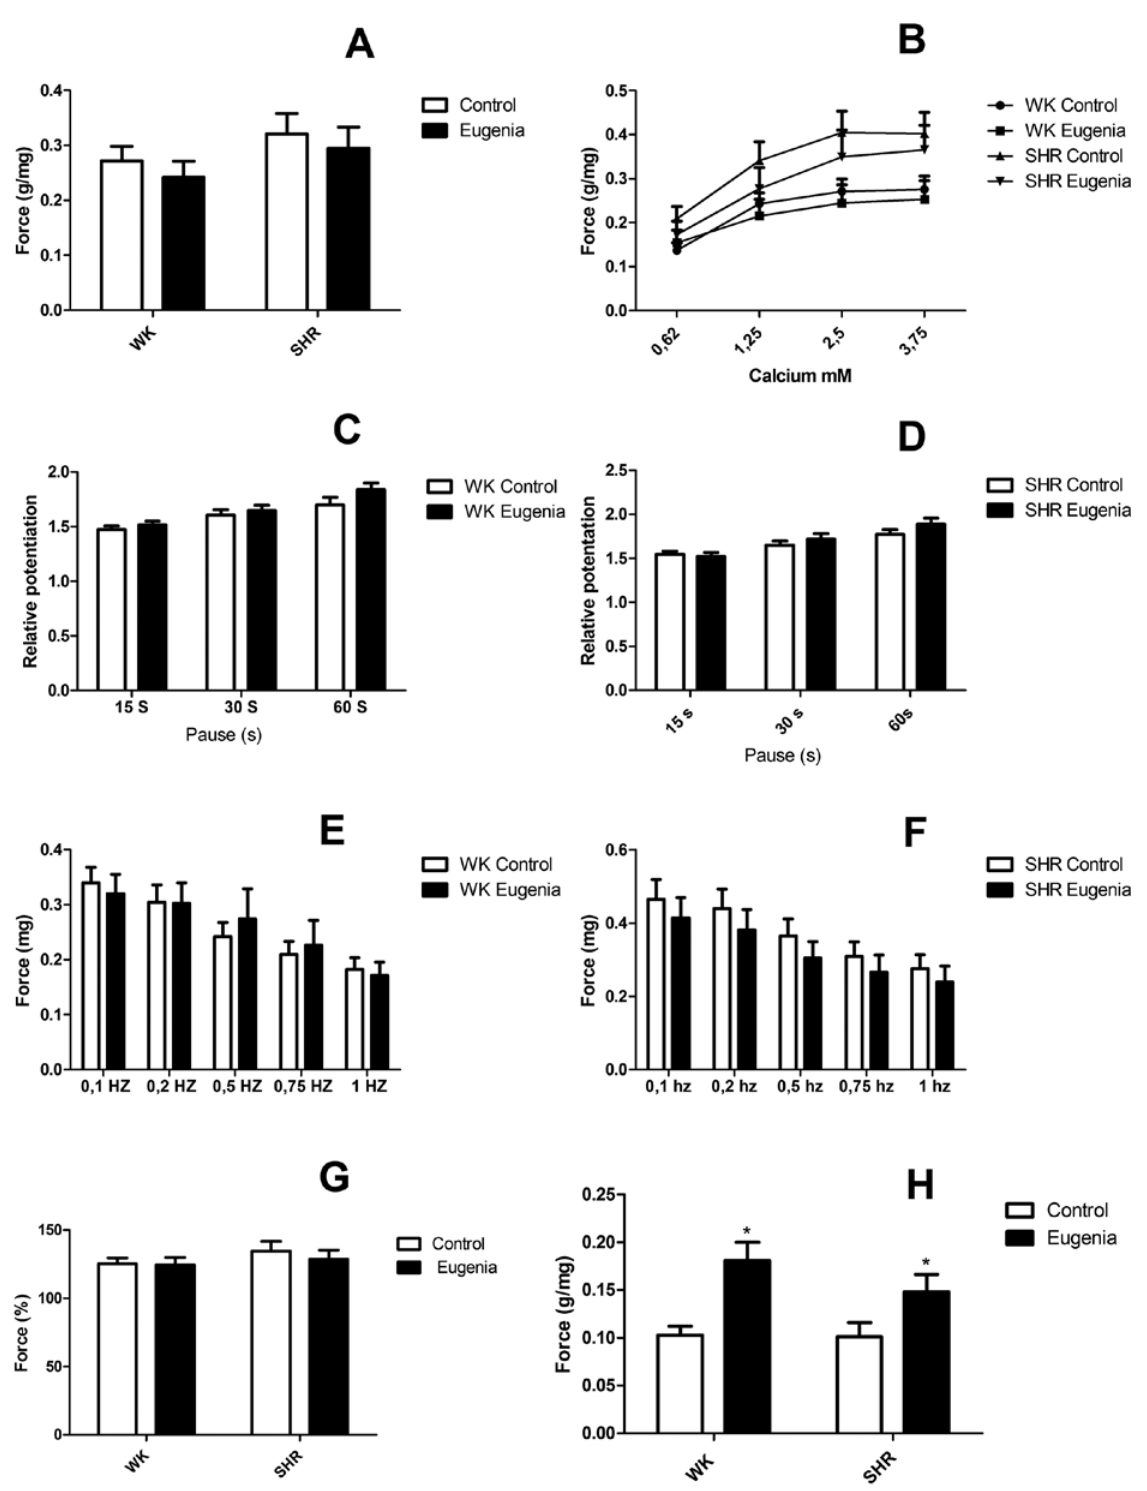
FIGURE 1 - Myocardial contractility of the Left ventricle (LV) papillary muscle of rats treated for 30 days with the essential oil of Eugenia sulcata leaves (10 mg/kg). Legend: (A) Isometric force. (B) Inotropic effect of calcium (0.62 - 3.75 mM CaCl (C) Relative potentiation after pauses (15, 30, and 60 s) in Wistar Kyoto (WK). (D) Relative potentiation after pauses (15, 30, and 60 s) in spontaneously hypertensive animals (SHR). (E) Strength of the different frequencies of electrical stimulation in WK. (F) Strength of the different frequencies of electrical stimulation in SHR. (H) Tetanic contractions. *p<0.05 vs Control. ANOVA and Student’s